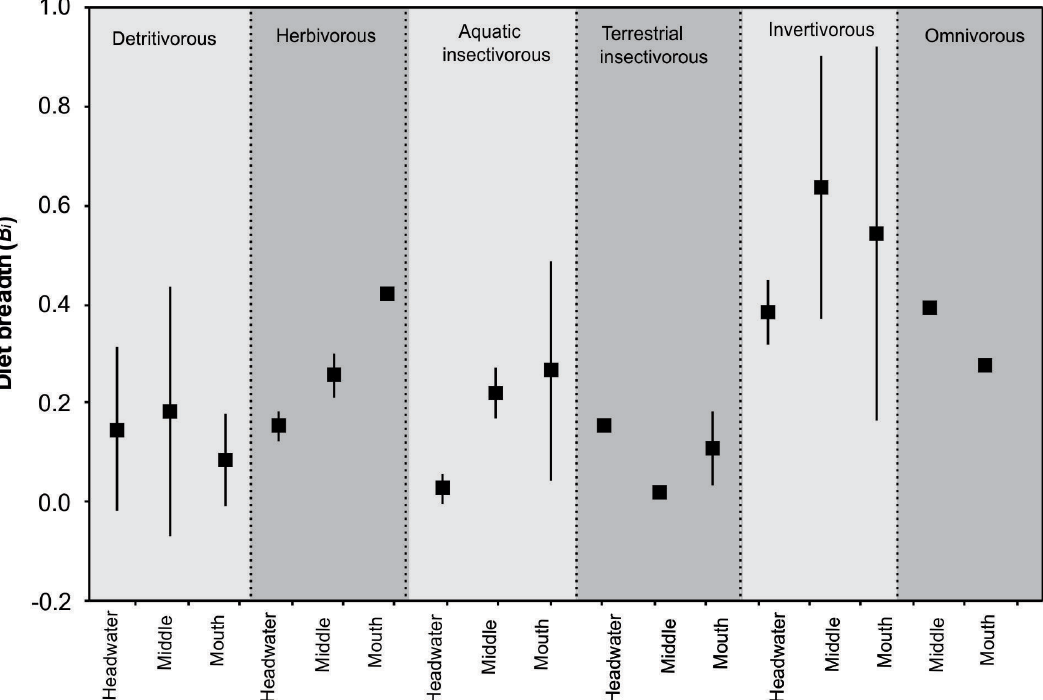
Figure 3. Mean ± standard deviation of the diet breadth ( B ) of fish trophic guilds along the longitudinal gradient of the Itiz